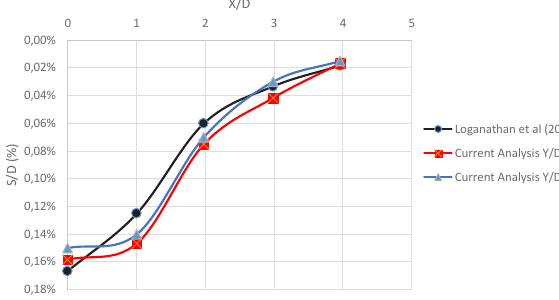
Fig. 18 Comparison of the present numerical analysis with centrifuge test results Figure 18: Comparison of the present numerical analysis with centrifuge test results.